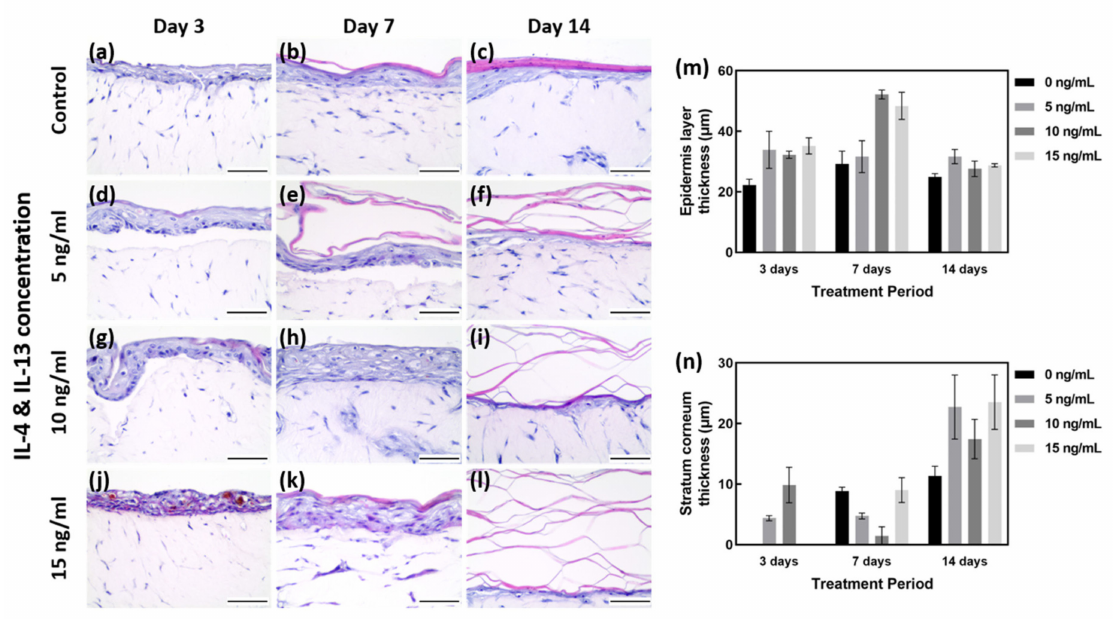
Figure 2. H&E staining of AD-HSE. ( a – c ) H&E staining of HSE cultured in general medium (without IL-4/IL-13 stimulation) for 3, 7 and 14 days as a baseline control. ( d – f ) H&E staining of AD-HSE stimulated with 5 ng/mL IL-4/IL-13 for 3, 7 and 14 days. ( g – i ) H&E staining of AD-HSE stimulated with 10 ng/mL IL-4/IL-13 for 3, 7 and 14 days. ( j – l ) H&E results of AD-HSE stimulated with 15 ng/mL IL-4/IL-13 for 3, 7 and 14 days. Scale bar is 50 µ m. ( m ) Graph quantified by measuring the thickness of all epidermis layers, including stratum corneum. ( n ) Graph quantified by measuring only the thickness of stratum